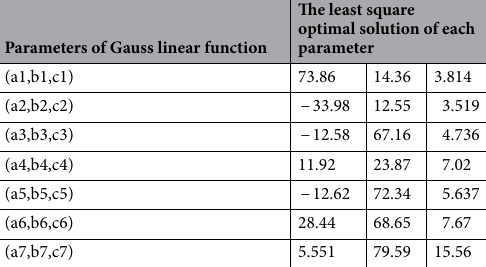
The least square optimal solution of each